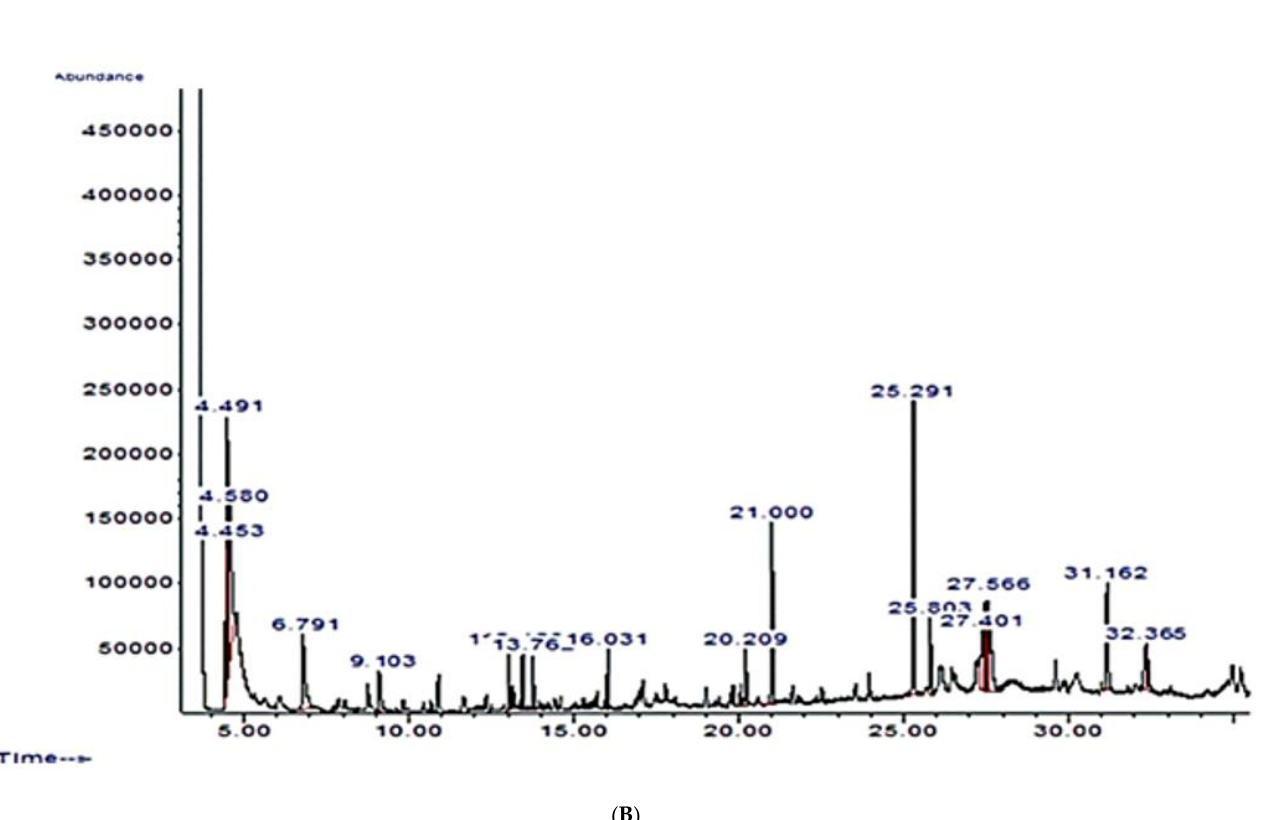
Figure 1. ( A ). Chromatograms of methanol extract of C.pepo by Gas Chromatography-Mass Spectrometry. ( B ): Chromatograms of methanol extract of C.pepo by Gas Chromatography-Mass Spectrometry.